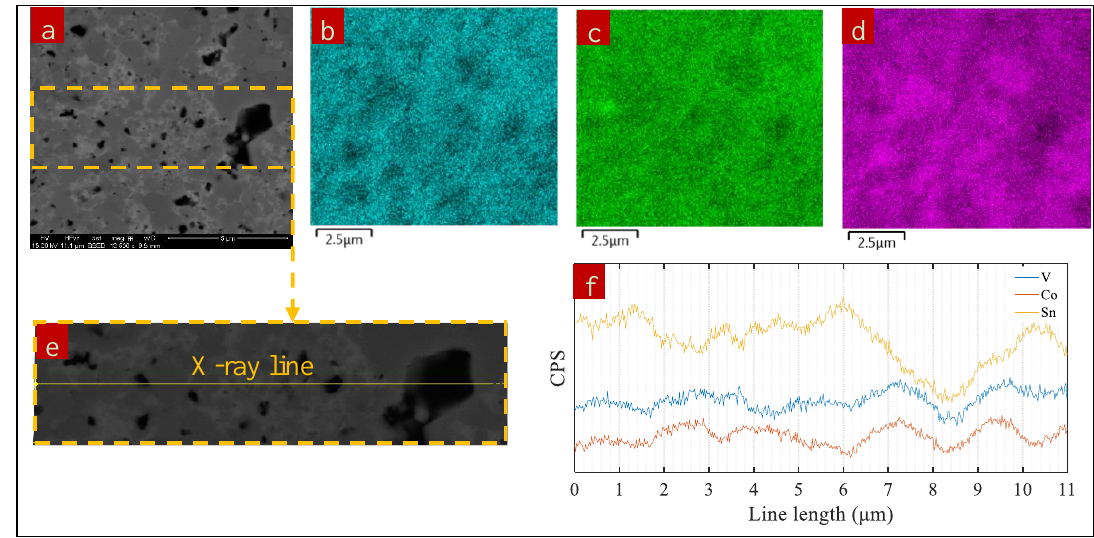
Figure 4. ( a ) BSE micrograph of the SPS-consolidated CoVSn composition and EDS-maps of ( b ) Co, ( c ) V, and ( d ) Sn. ( e ) X-ray line scan and ( f ) element distribution along with the X-ray line scan.